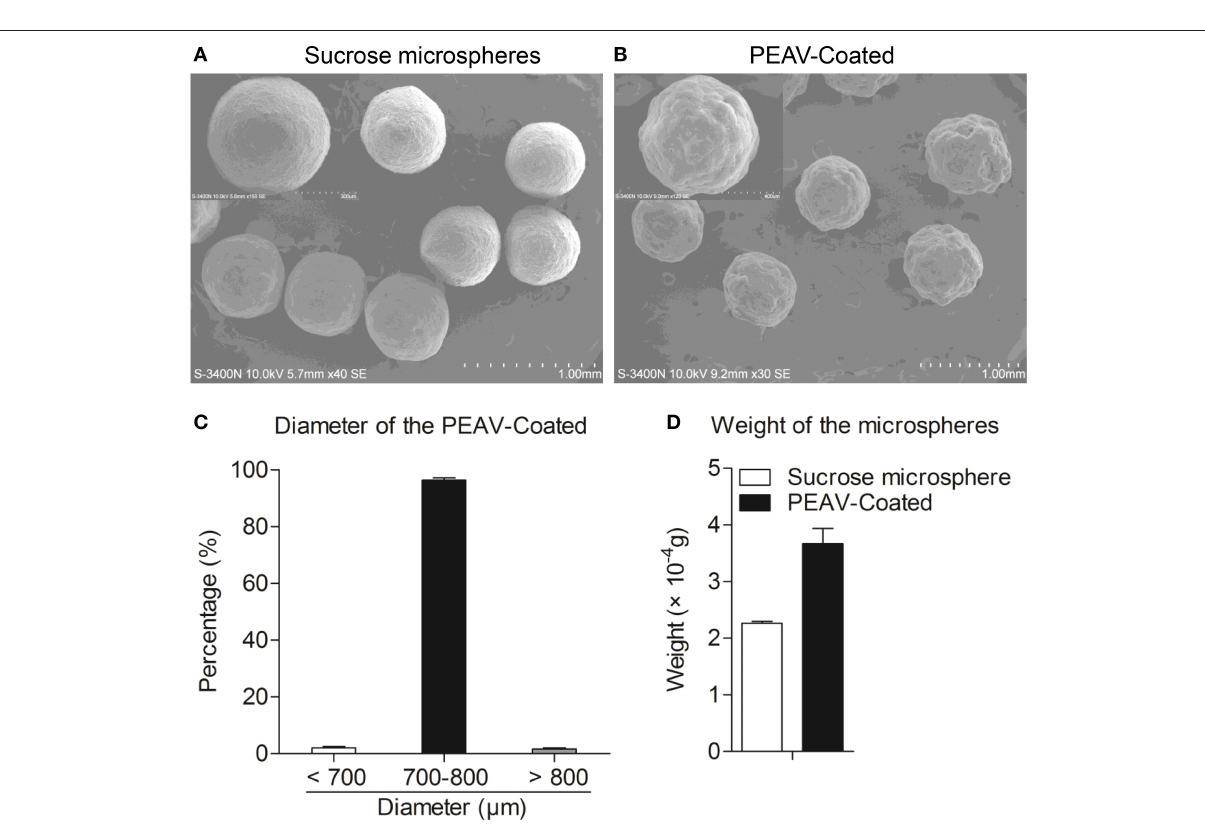
FIGURE 2 | Appearance, size distribution, and weight gain of PEAV-Coated. Scanning electron micrographs of sucrose microspheres (A) and PEAV-Coated (B) (scale bar 1.0mm, 300 µ m or 400 µ m in A,B ). (C) Size distribution of freshly prepared PEAV-Coated was measured using a Vernier caliper and data were plotted as the percentage of different diameters. (D) One hundred freshly prepared PEAV-Coated or sucrose microspheres were randomly selected and measured with Electronic scales to calculate the weight gain of the single microsphere. Results are representative of three independent experiments. Data are represented as mean ± SD, n =